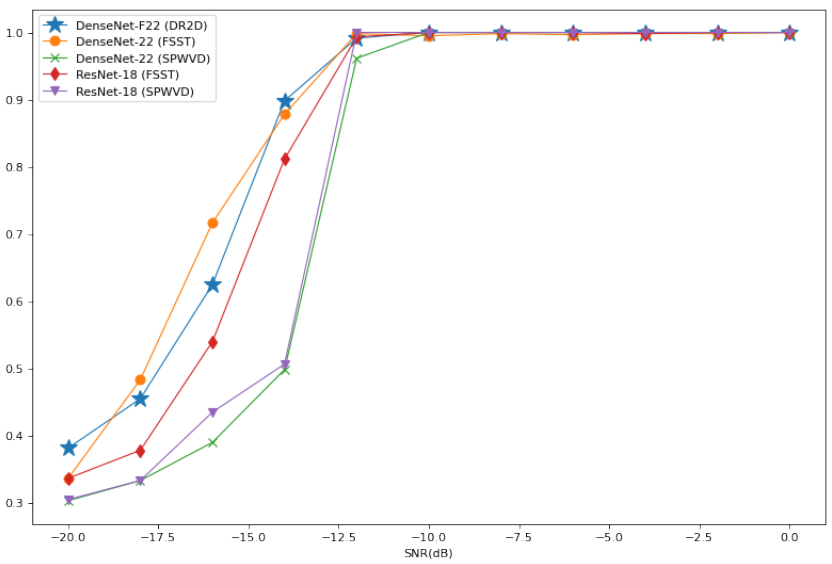
Figure 13. The average recognition accuracy curves of DenseNet-F22, DenseNet-22, and ResNet-18 feature recognition networks in environments with different